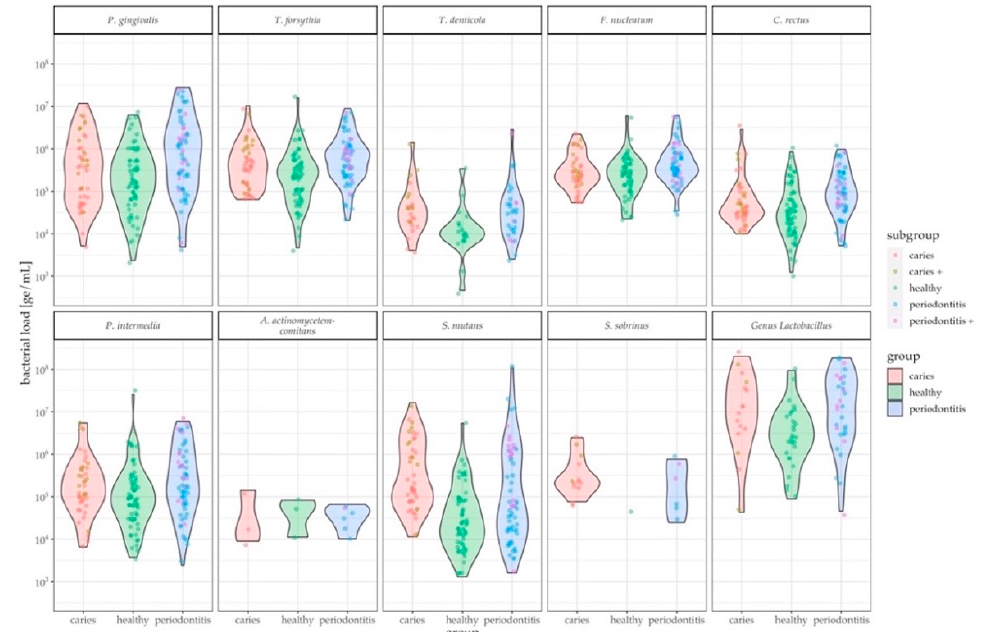
Figure 4. Quantity of each bacterial strain in saliva, in genome equivalents per mL (ge / mL), detected by the POC compatible qPCR assays for each study group. Counts within the violins are colored based on corresponding clinical subgroups (within the caries violin: yellow = caries patients with periodontitis, red = pure caries patients; within periodontitis violin: violet = periodontitis patients with caries, blue = pure periodontitis patients; healthy patients do not have subgroups, all counts in green. In general, healthy subjects can be statistically distinguished from periodontitis patients for all targets except A. actinomycetemcomitans and S. sobrinus , the most prominent being P. gingivalis , T. forsythia and C. rectus . A difference between caries and periodontitis groups can only be seen for S. mutans .